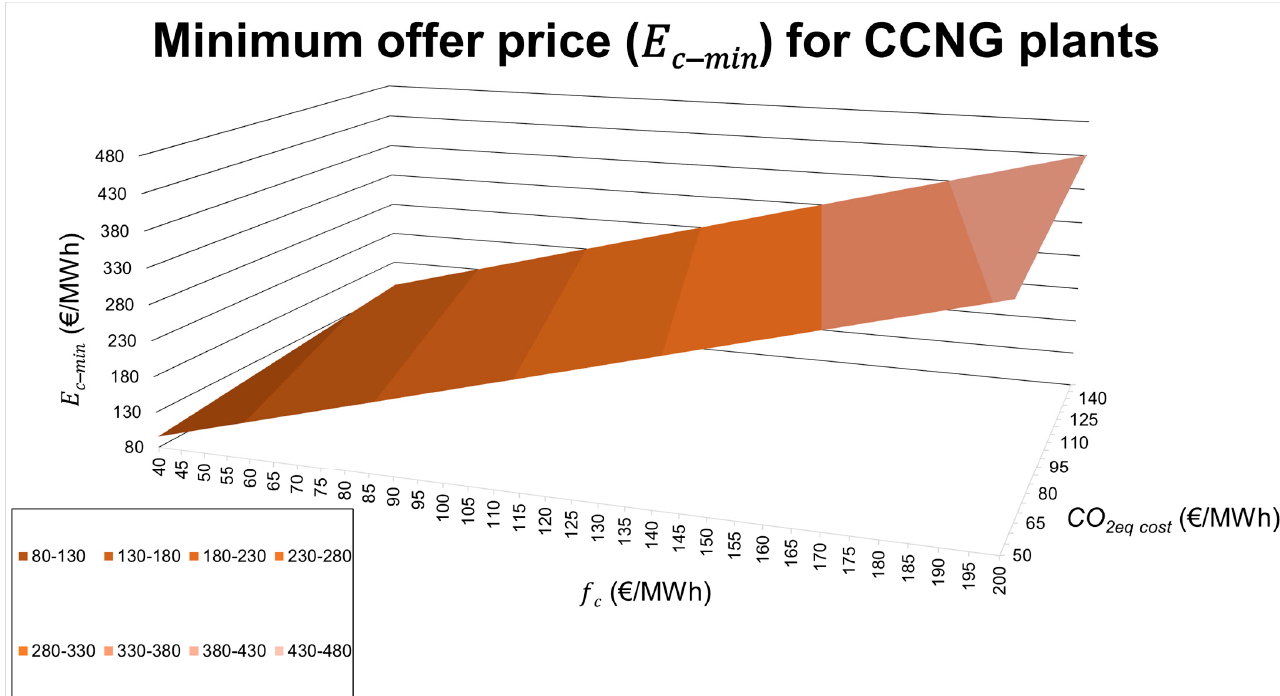
Figure 8. 𝐸 (cid:3030)(cid:2879)(cid:3040)(cid:3036)(cid:3041) for CCNG plants for different fuels and emission costs. Figure 8. E c − min for CCNG plants for different fuels and emission